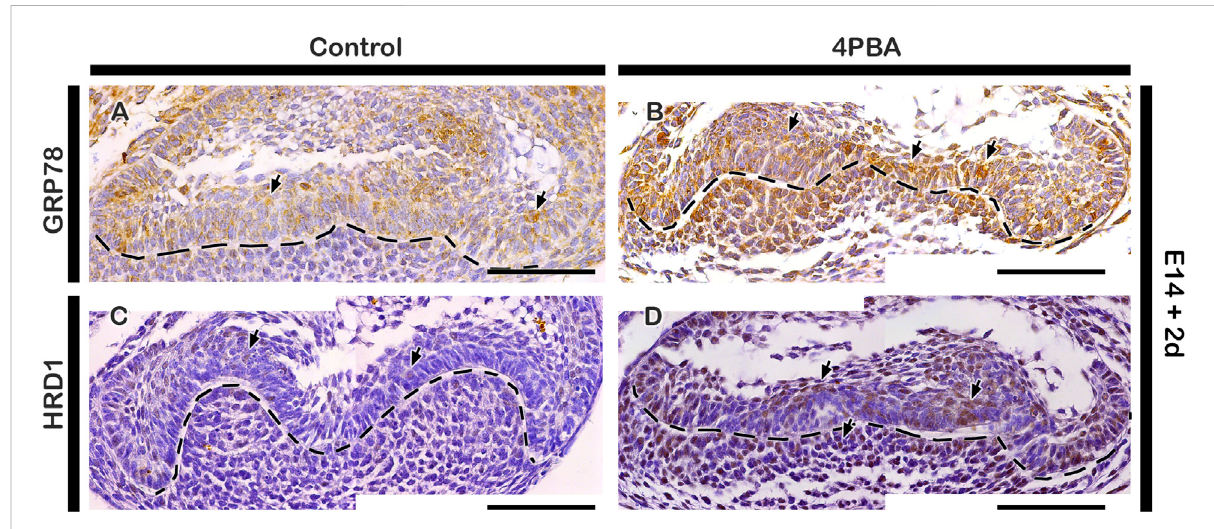
FIGURE 3 Localization patterns of GRP78 and HRD1. In vitro organ cultivation at E14 for 2 days showing increased localizations of GRP78 and HRD1 in both epithelium and mesenchyme of 4PBA treated teeth germs compared to controls (A – D) . Tissues are counterstained with hematoxylin (A – D) . Arrows indicate immunostaining and TUNEL positive cells (A – D) . Dotted lines demarcate the epithelial boundary (A – D) . Scale bars: 50 μ m (A – D) .